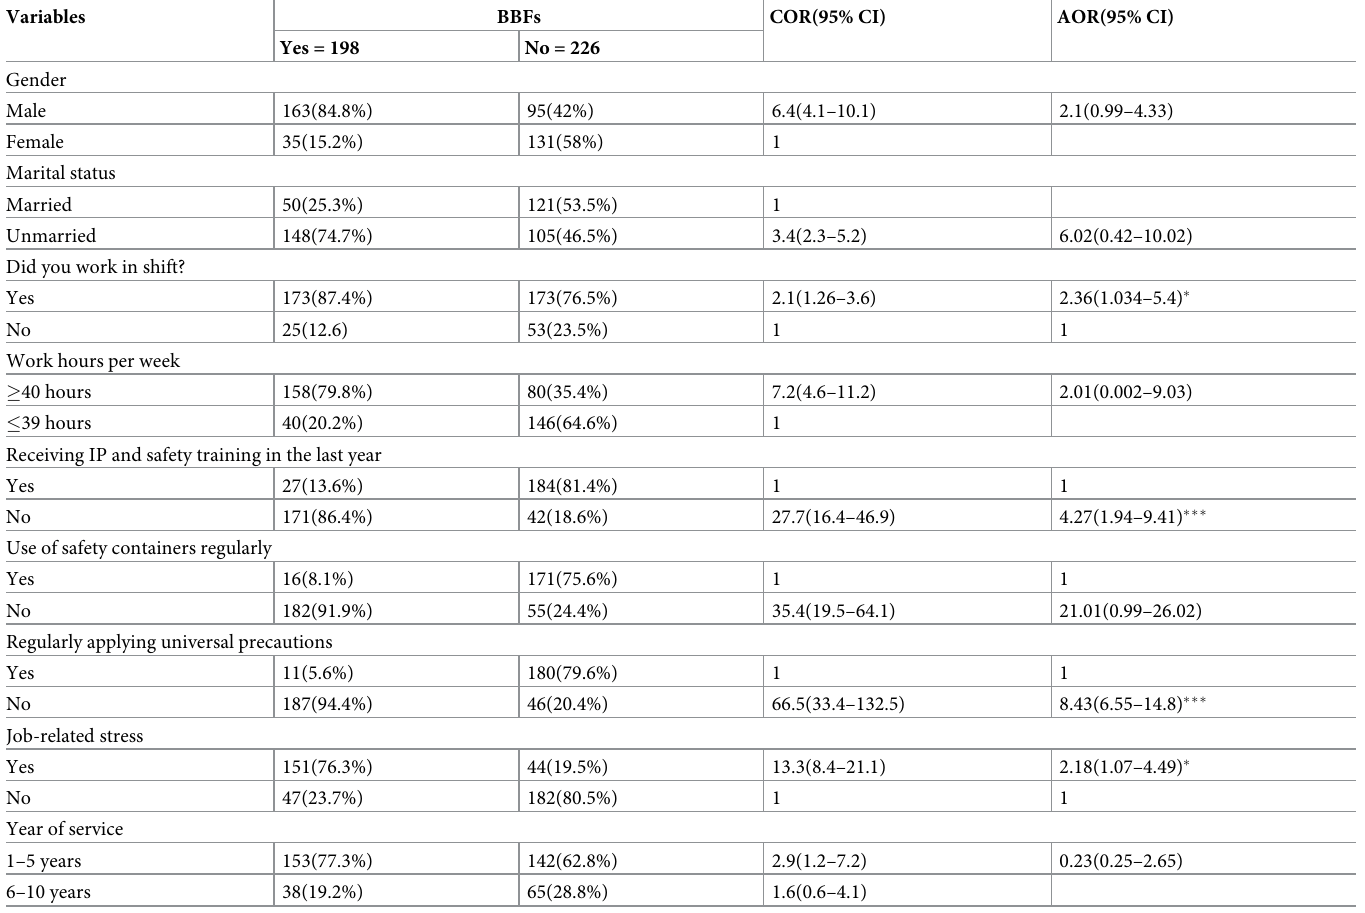
Table 3. Predictors of BBFs among midwives working in public health institutions of Addis Ababa city, Ethiopia 2020.